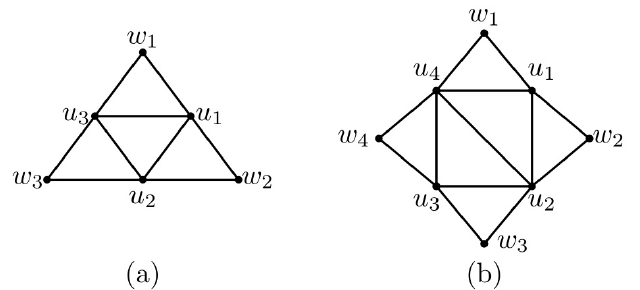
Figure 1. ( a ) The sun S 3 . ( b ) A sun S 4